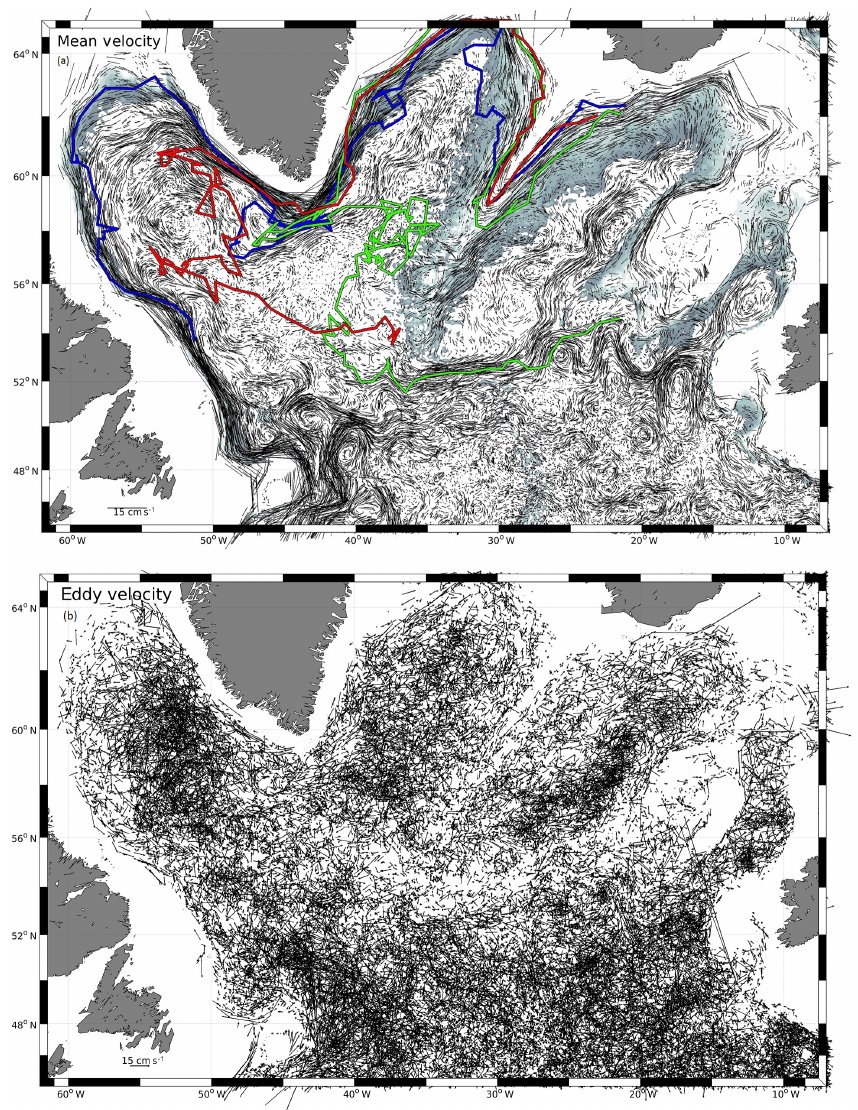
Figure 3. Mid-depth circulation (a) in the western SPNA from ∼ 38500 Argo deep drifts (1000 or 1500m parking depth) derived from the YoMaHa’07 data. This is an attempt to present the advective contribution of the flow field at each measurement location; i.e., for each measured 10-day drift vector (for details of the processing see text). Colored lines for selected float trajectories (deployed in the Iceland Basin); blue shaded area is for the topographic depth range (1500 to 2500m). The residual (b) is thought to be u (cid:48) , the eddy velocity contribution to the flow